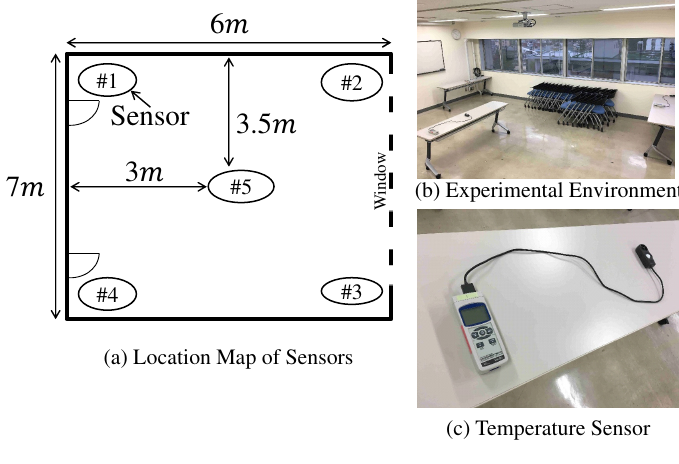
Figure 10. Overview of experimental evaluation.